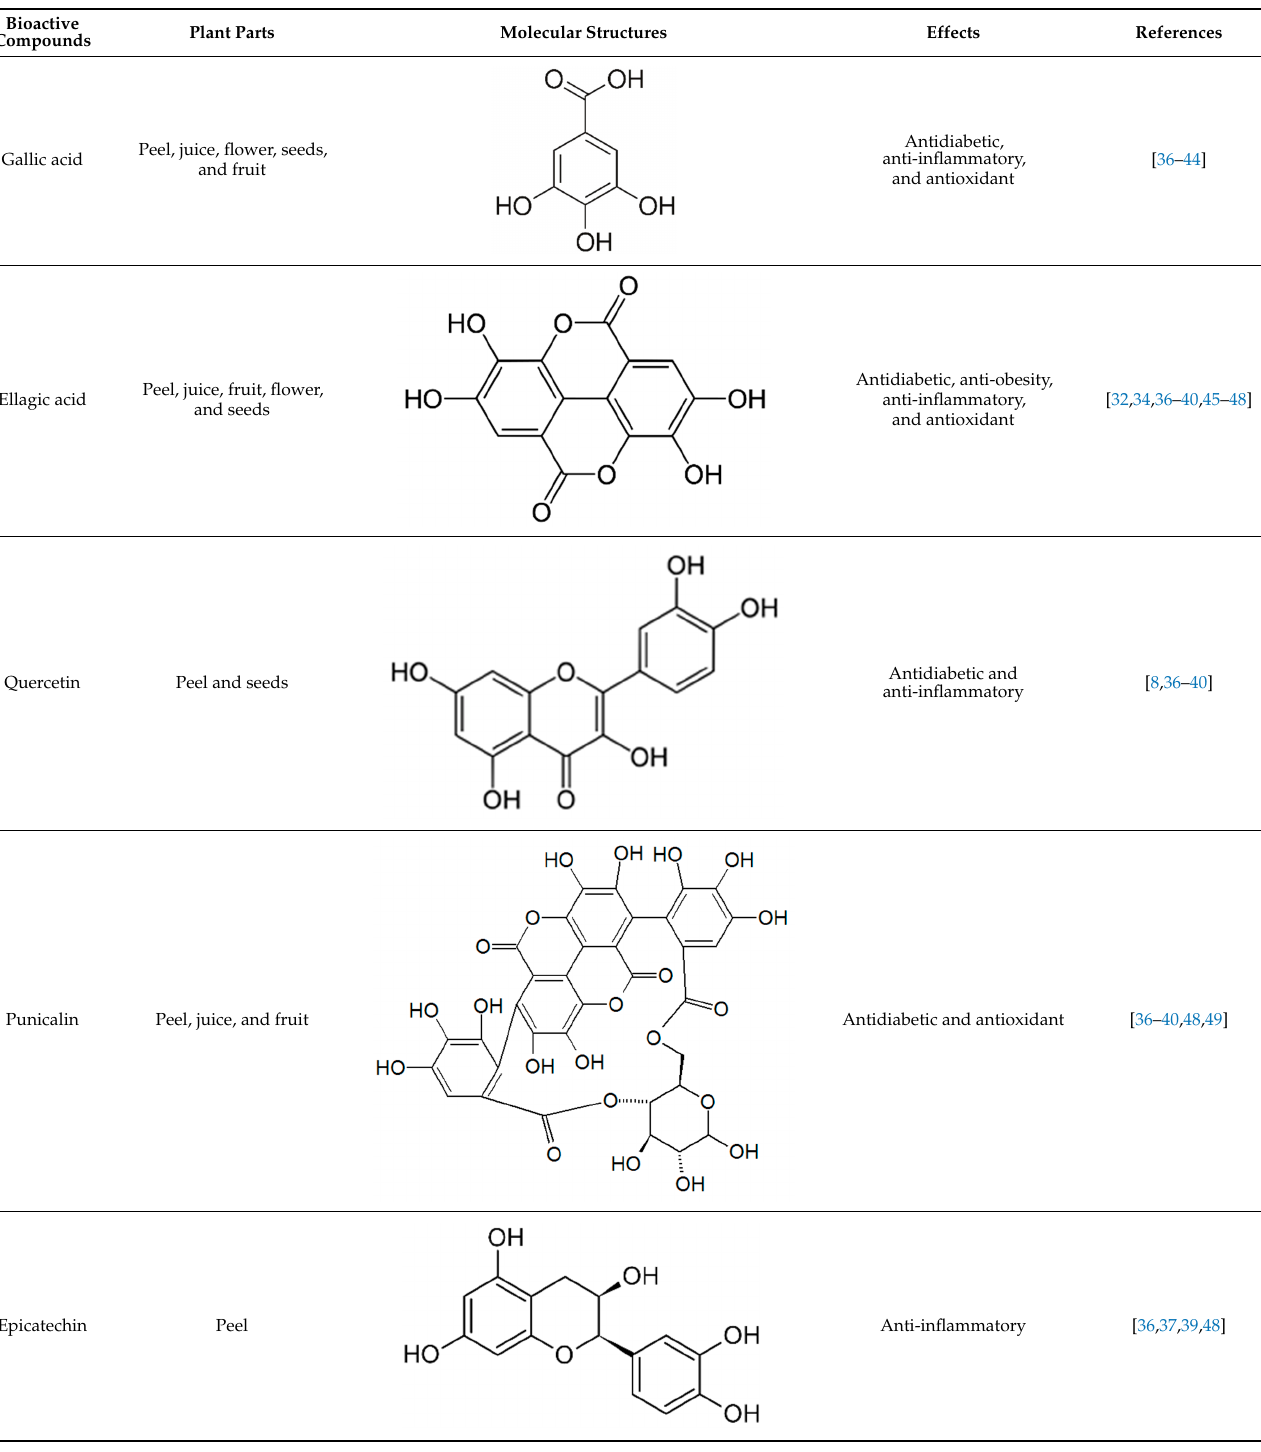
Table 1. Bioactive compounds of P. granatum and its actions on the risk factors related to MetS.